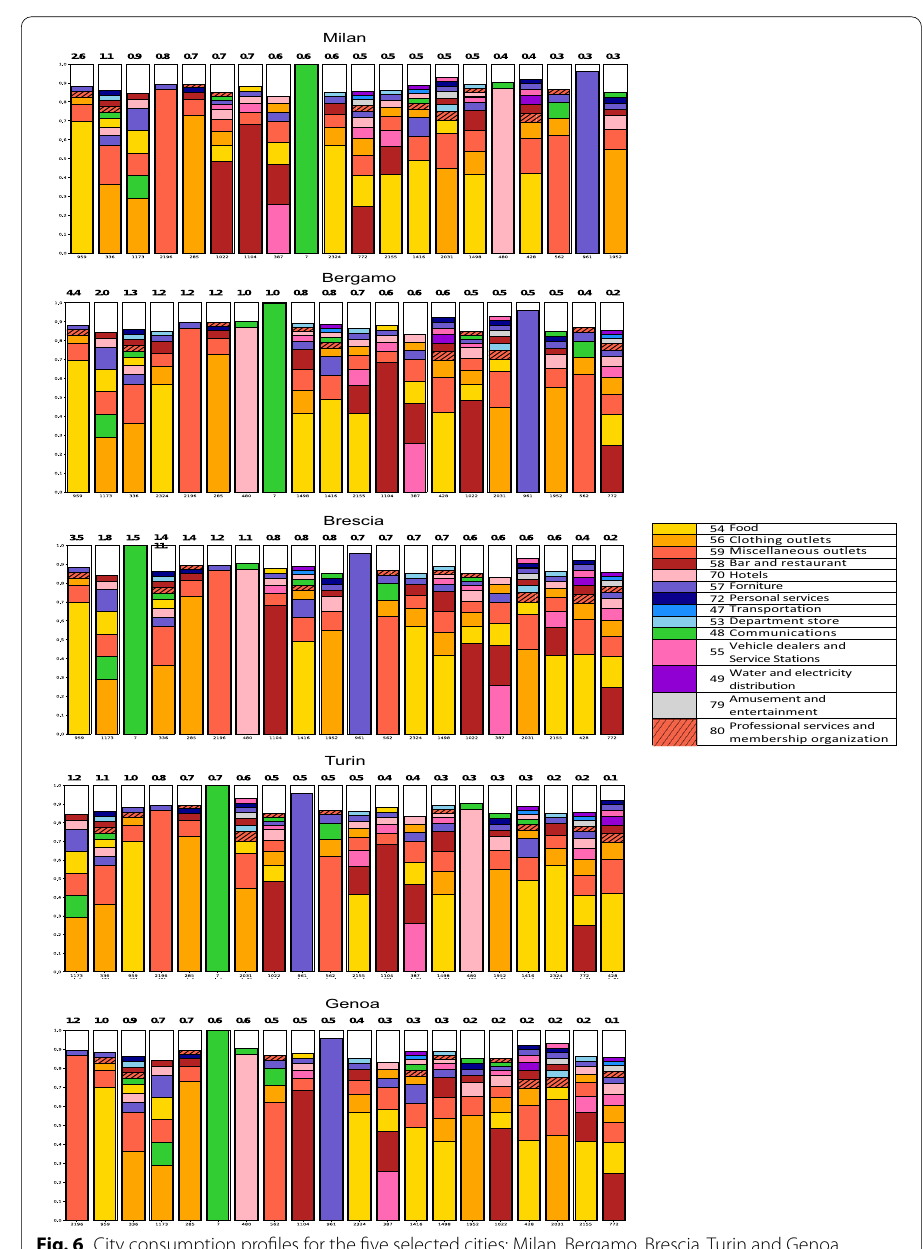
Fig. 6 City consumption profiles for the five selected cities: Milan, Bergamo, Brescia, Turin and